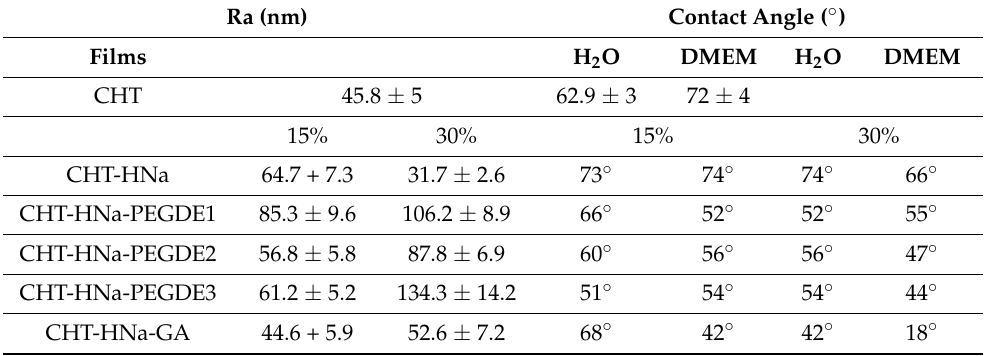
Table 5. Roughness and contact angle of GA crosslinked and PEGDE crosslinked chitosan/HNa